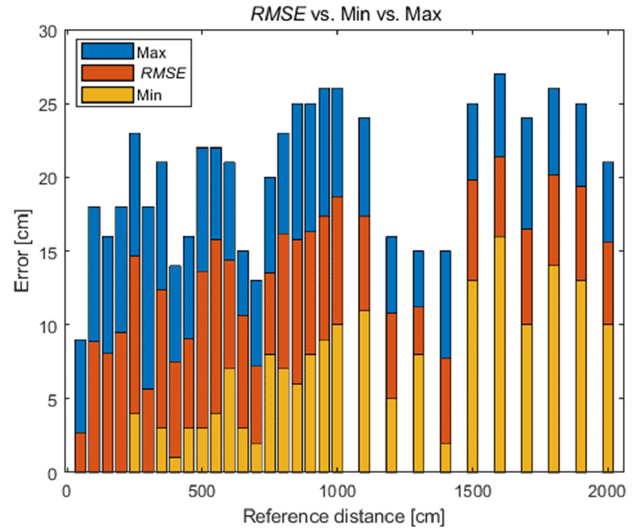
Figure 7. Change in 𝑅𝑀𝑆𝐸 with distance.